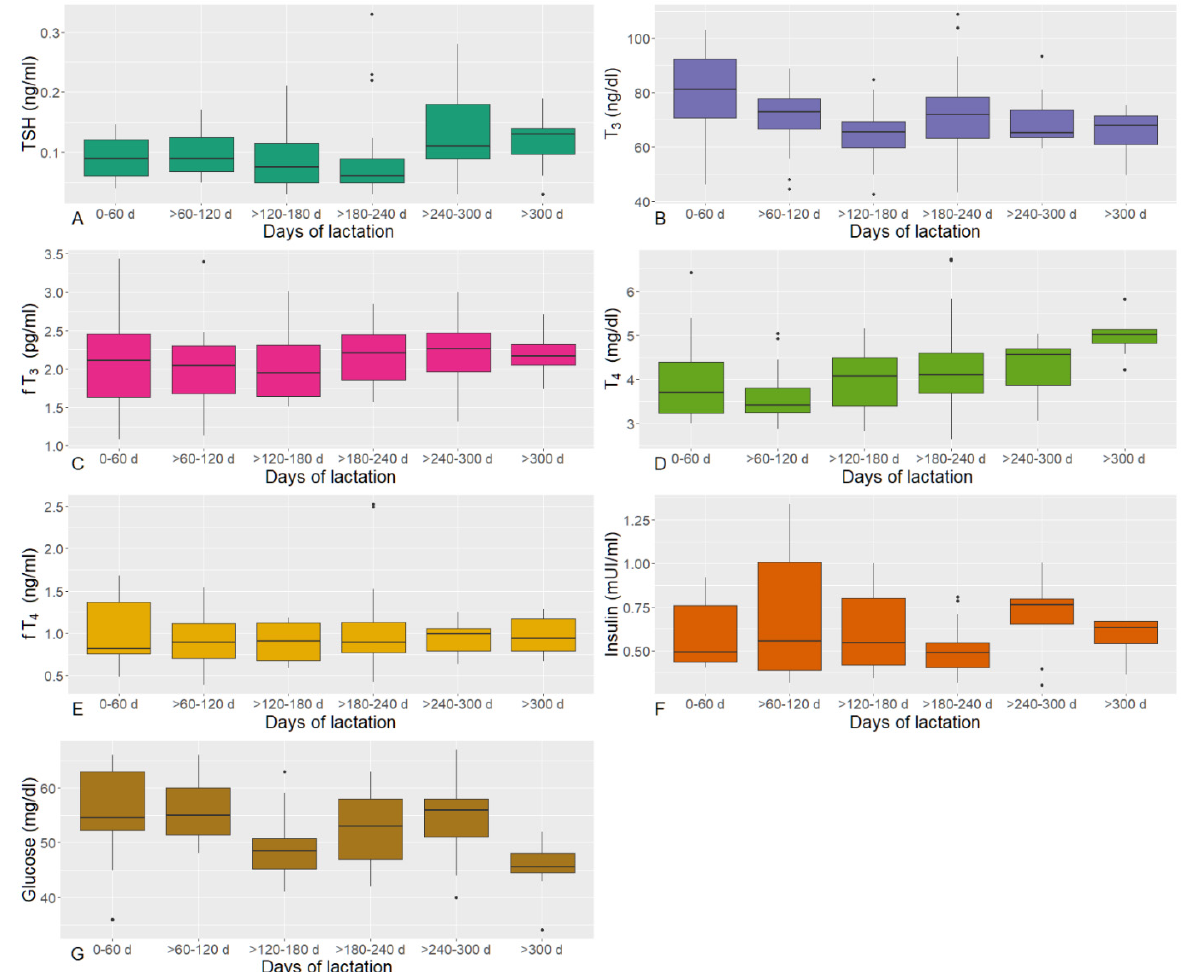
Figure 2. Boxplots of circulating thyroid ‐ stimulating hormone (TSH, A ), total triiodothyronine (T 3 , B ), free triiodothyronine (fT 3 , C ), total thyroxine (T 4 , D ), free thyroxine (fT 4 , E ), insulin ( F ), and glucose ( G ) in lactating cows.